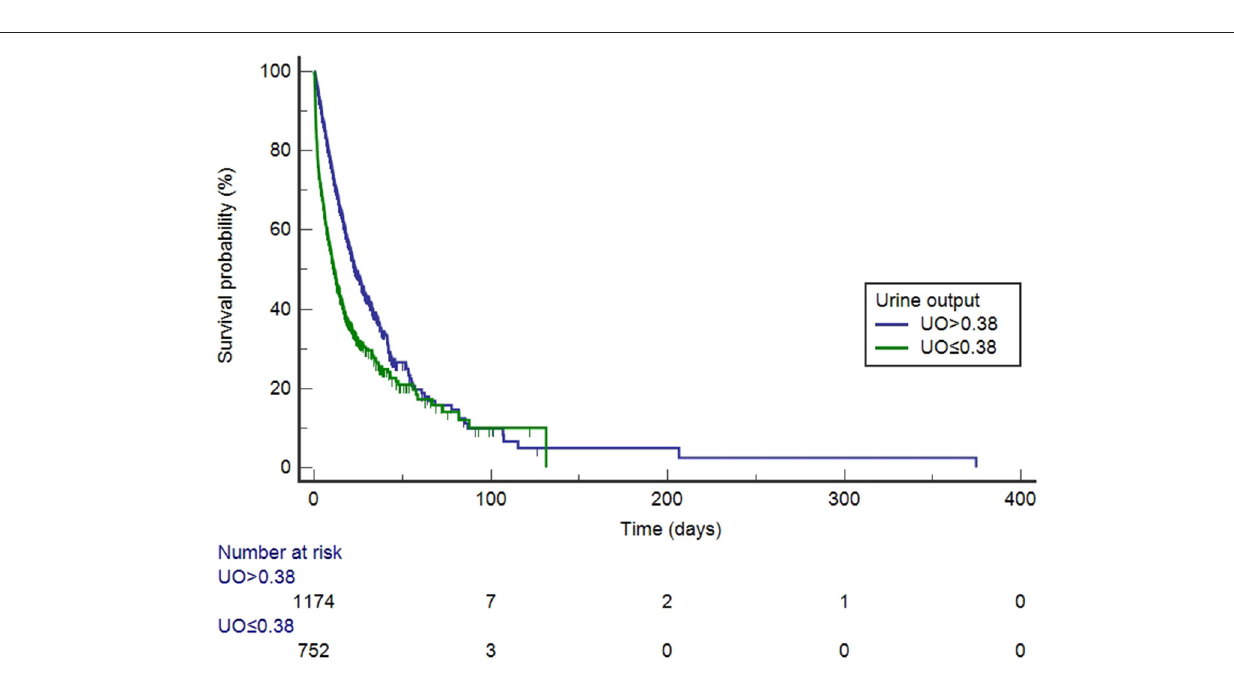
before, it still had approximately twice the risk of death (1.7879 times) compared to the high-UO group. It can be seen that the UO on the first day of admission does not depend on whether complicated with AKI and whether to undergo RRT or diuretic